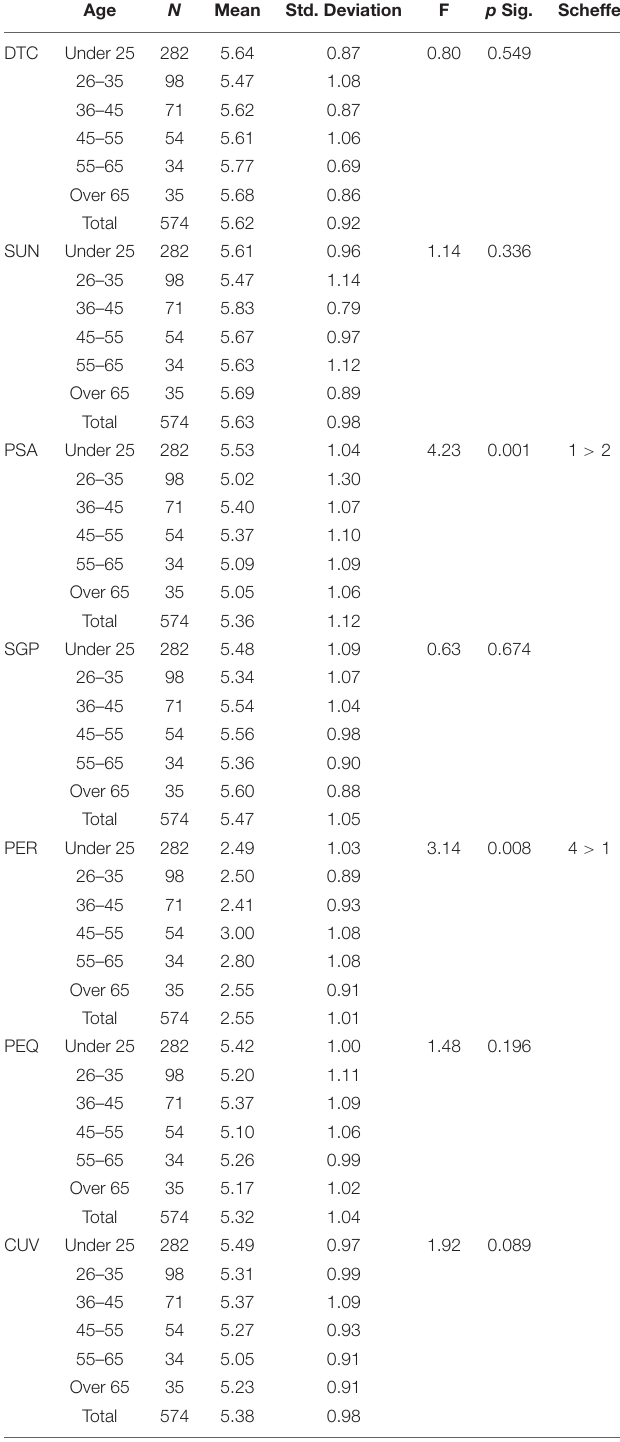
TABLE 9 | Analysis of variance by